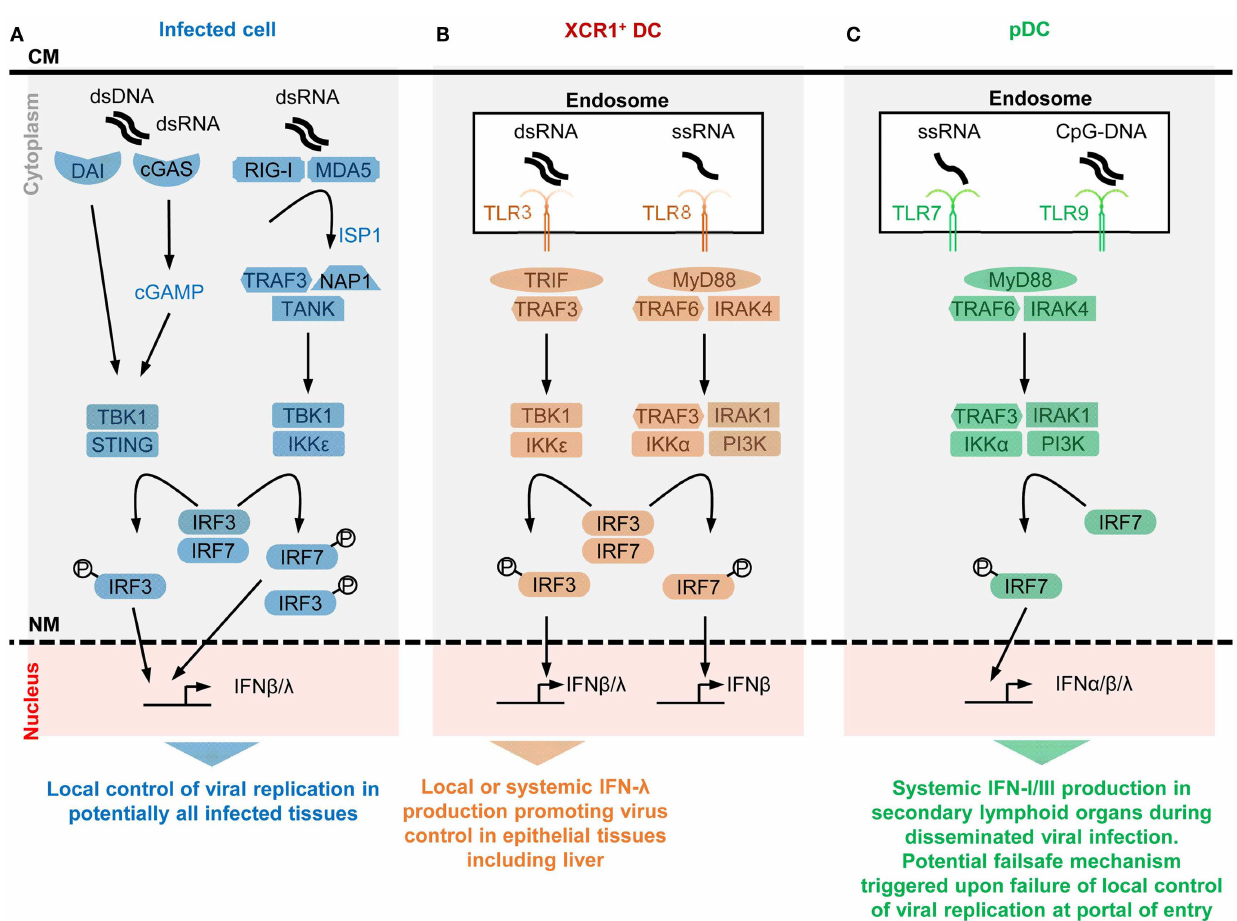
FIGURE 1 |A simplified model of the potential contributions of selective sensors and cell types to IFN production during viral infections . Different innate immune recognition receptors are involved in sensing various types of viral nucleic acids in distinct categories of cells during viral infections, which may promote different types of anti-viral defenses. For each selected sensor shown, the types of viral nucleic acids recognized and the downstream signaling cascade induced are represented in a simplified, schematic manner. The potential specific role of each cell type in anti-viral defenses is also indicated at the bottom of each panel. (A) Potentially all types of infected cells can detect endogenous viral replication through cytosolic sensors triggering their local production of IFN- β / λ to control viral replication in an autocrine and paracrine fashion in infected tissues. (B) Uninfected XCR1 + DCs selectively produce high levels of IFN- λ and IFN- β upon engulfment of materials containing dsRNA and the consecutive triggering ofTLR3 in endosomes.The receptor of IFN- λ is mostly expressed by epithelial cells. Hence, XCR1 + DCs might be involved in inducing local IFN responses in virally infected epithelial